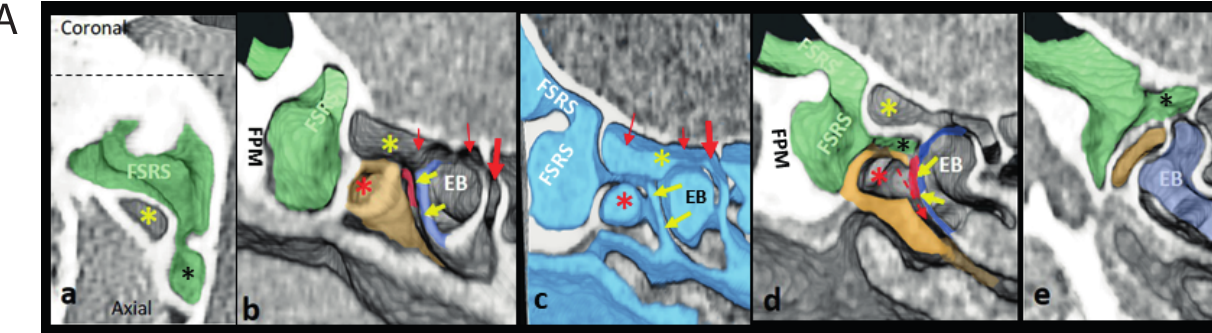
Figure 7. The pronounced inferior/anterior/medial/lateral expanding FSRS. A. 2. The infero-anterior and lateral-medial expanding FSRS. a.-e. 3D oblique axial image (Fig. a) and sagittal images (right side) shown sequentially from medial to lateral, reveal the expansion of the FSRS (green outline) postero-laterally, and antero-medially expanding between the frontal process of the maxilla (FPM) and the anterior EUP (gold outline) / red arrows). The posteriorly extending FSRS (black asterisk) directly communicates with the EI (red outline; yellow arrows). The IS-EUP (red